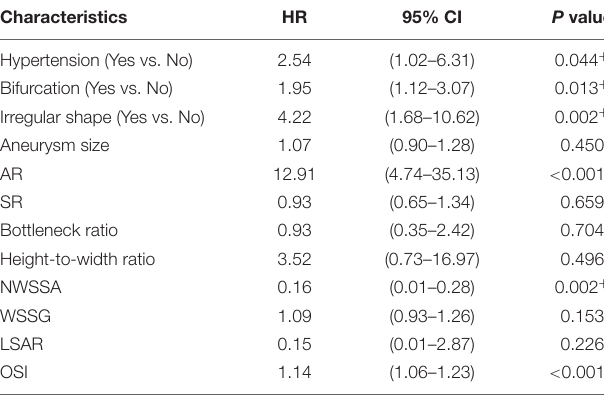
TABLE 2 | The morphological and hemodynamic features of IAs in the primary cohort. Stable IAs n = 341